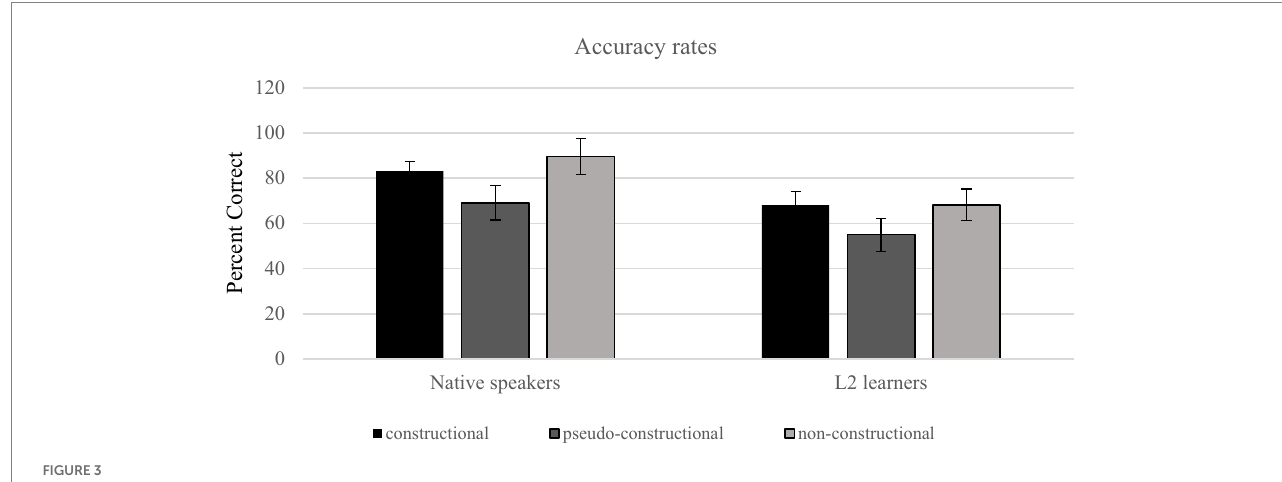
FIGURE 3 Accuracy rates for L1 group and L2 group. The error bars represent SDs. ANOVA also revealed a significant main effect for language background.